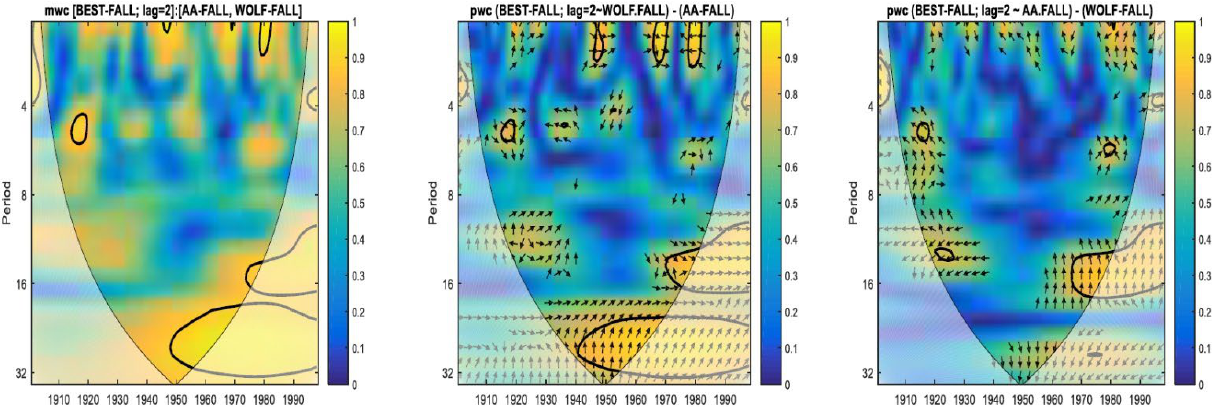
Figure 9. Mwc ( left panel ) between fall BEST at lag = 2, and the two predictors aa (AA) and Wolf Number (WOLF); partial wavelet coherence ( pwc ) between BEST and Wolf number, excluding the effect of aa ( middle panel ), and pwc between BEST and aa , excluding the effect of Wolf number ( right panel ).